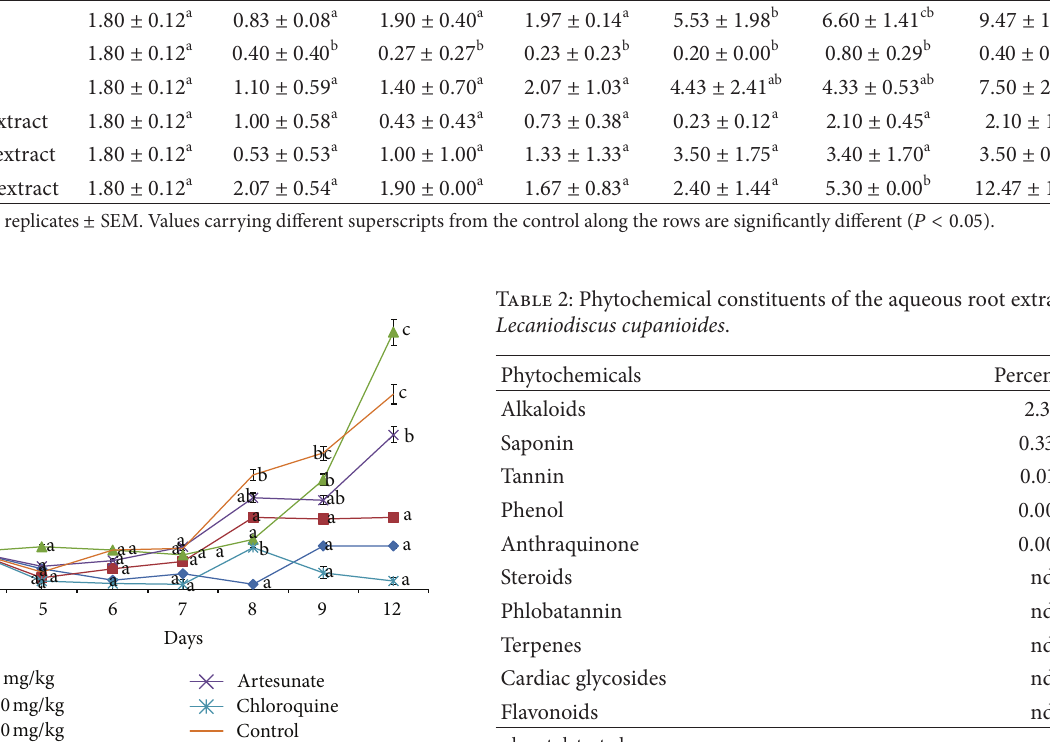
Table 1: Parasitaemia changes following treatment with different doses of aqueous extract of Lecaniodiscus cupanioides and standard drugs. Treatments